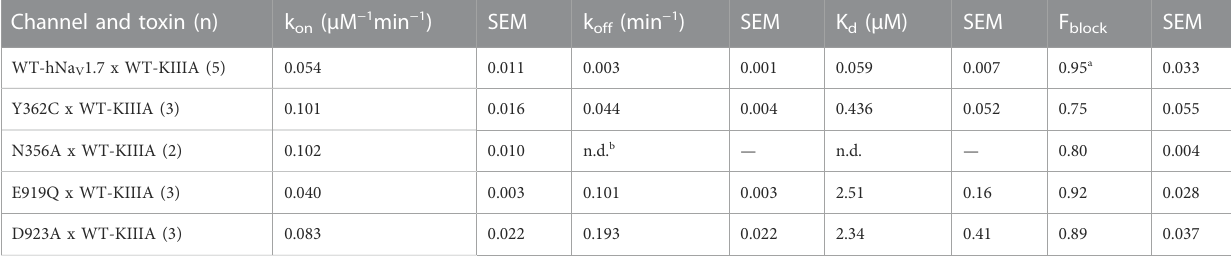
TABLE 2 Block of hNa V 1.7 mutants by KIIIA. Fractional block at saturating concentrations determined from extrapolation from kinetic data. Channel and toxin